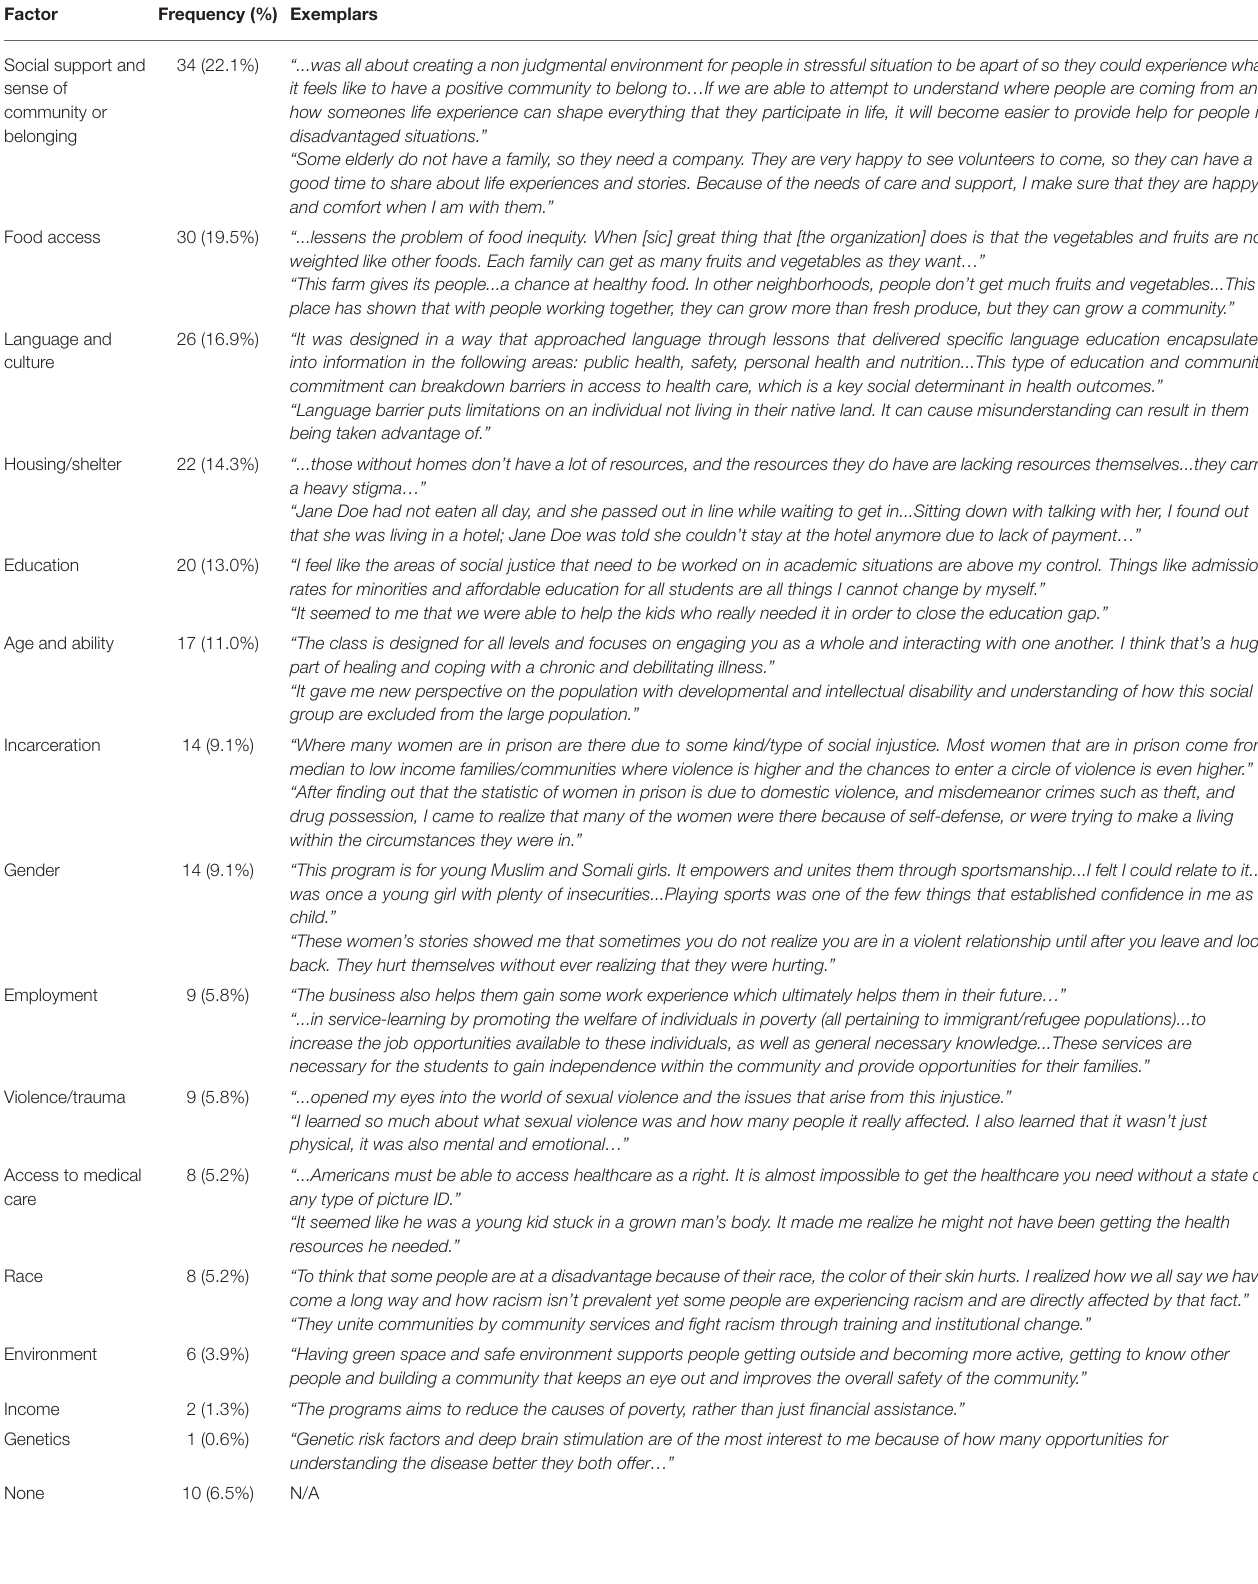
TABLE 1 | Frequency and exemplar quotes of socioeconomic, behavioral, biological, environmental, and other factors that impact human health and contribute to health disparities as described in student reflections from Foundations of Public Health (Fall 2015–Spring